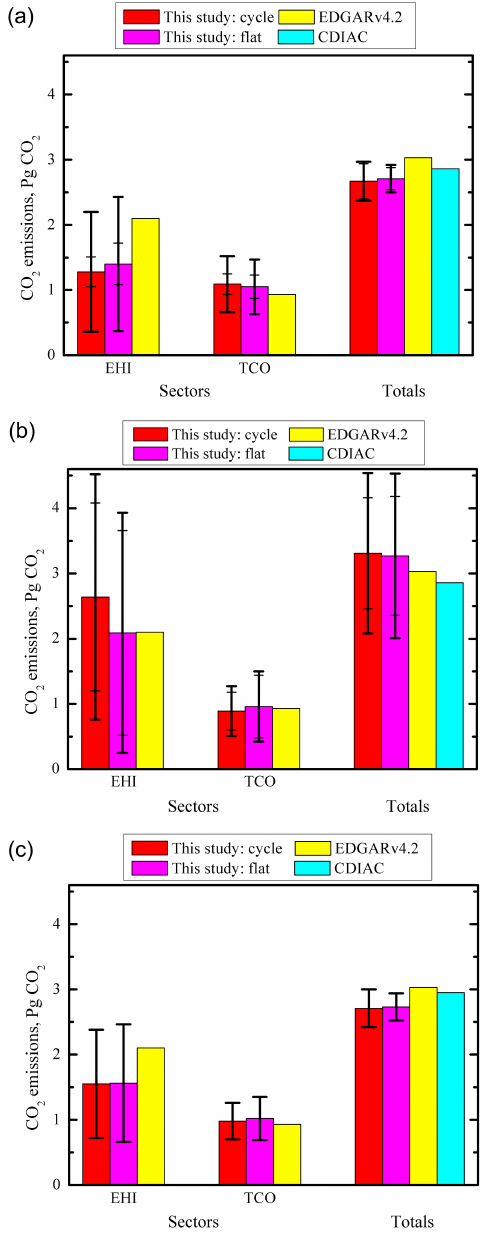
Figure 11. Hybrid estimates of the fossil-fuel CO 2 emissions ) from the study region in ( ˆ E CO 2 sc , ˆ E CO 2 s,tot ˆ E CO 2 , and ˆ E CO 2 comb,c comb,tot comparison with the data of the EDGAR v4.2 and CDIAC emission inventories. The estimates were obtained either from (a) only NO x and (b) only CO or (c) from both NO x and CO measurements. The “partial” and “full” 68.3% confidence intervals are also shown: the partial intervals (depicted by narrow brackets and not shown for the combined CO 2 emission estimates) are determined only by uncer- tainties in the top-down estimates of NO x or CO emissions, while the full intervals also take into account probable uncertainties in the conversion